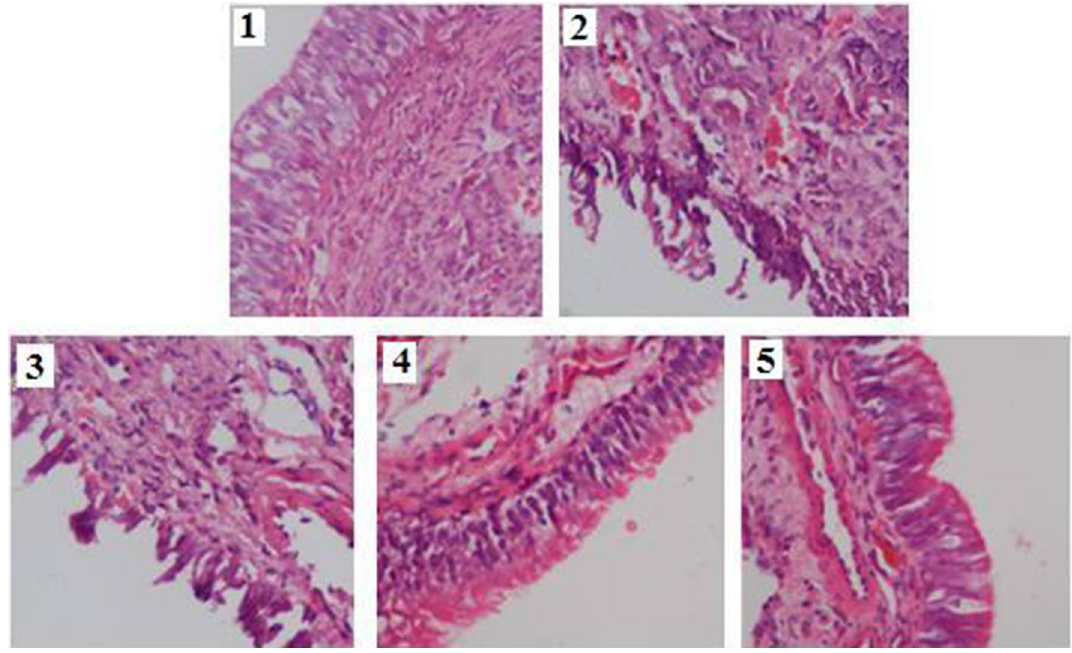
Figure 3. Representative HE staining of sinonasal mucosa from different groups. The number of photos represented group 1, 2, 3, 4 and 5,